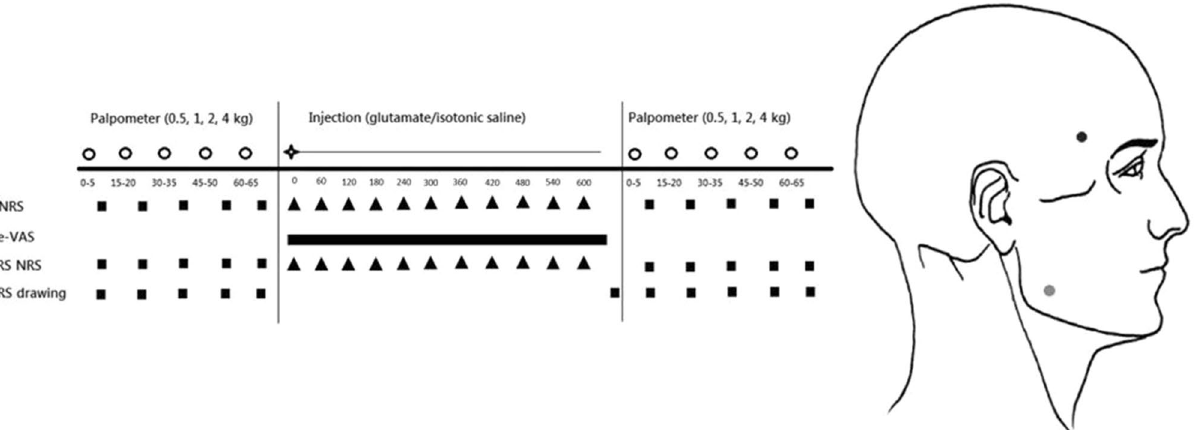
Figure 1. A schematic illustration of the experimental protocol. The white circles indicate one of the repetitions of the forces. The injection (star) was either glutamate or isotonic saline. The numbers indicate the time in seconds. The black squares indicate when the different parameters were assessed. The black stripe indicates a continuously-updated e-vas scale. The referred sensation intensity (RS NRS) and referred sensation drawing (RS drawing) were only collected when a referred sensation was present. Both sessions were performed with at least 48 h between them. The place of injection (black dot) and palpation (grey dot) can be on the left or right side of the face. Copyright International RDC/TMD Consortium Network. Available at http:// www. rdc- tmdin terna/ onal. org. Version 12May2013. No permission required to reproduce, translate, display, or